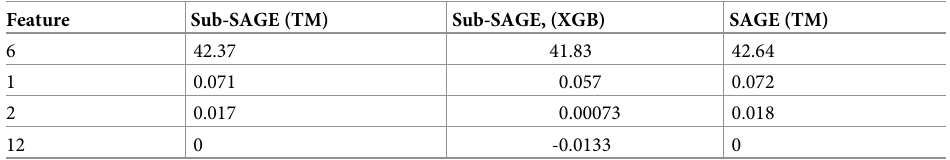
Table 2. Exact Sub-SAGE and SAGE value for features 1, 2, 6 and 12 using true model in (19), denoted TM, together with estimated Sub-SAGE value using the trained XGBoost model, denoted XGB, based on syntetic data based on